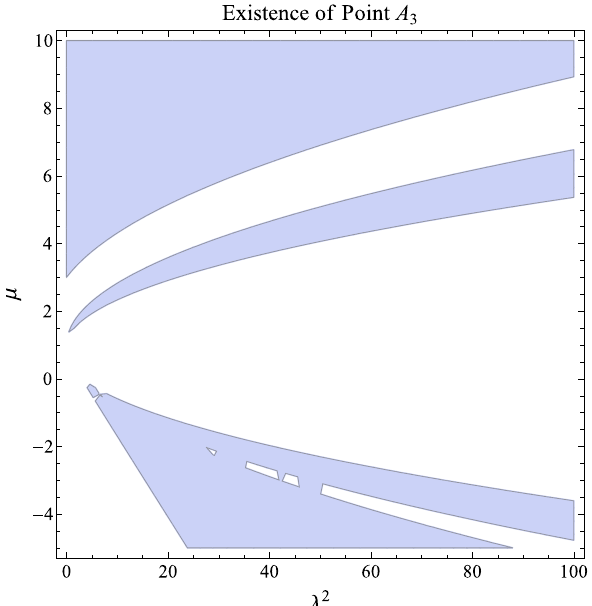
Fig. 7 Region plot in the space { λ,μ } where the critical point A 3 is physically accepted